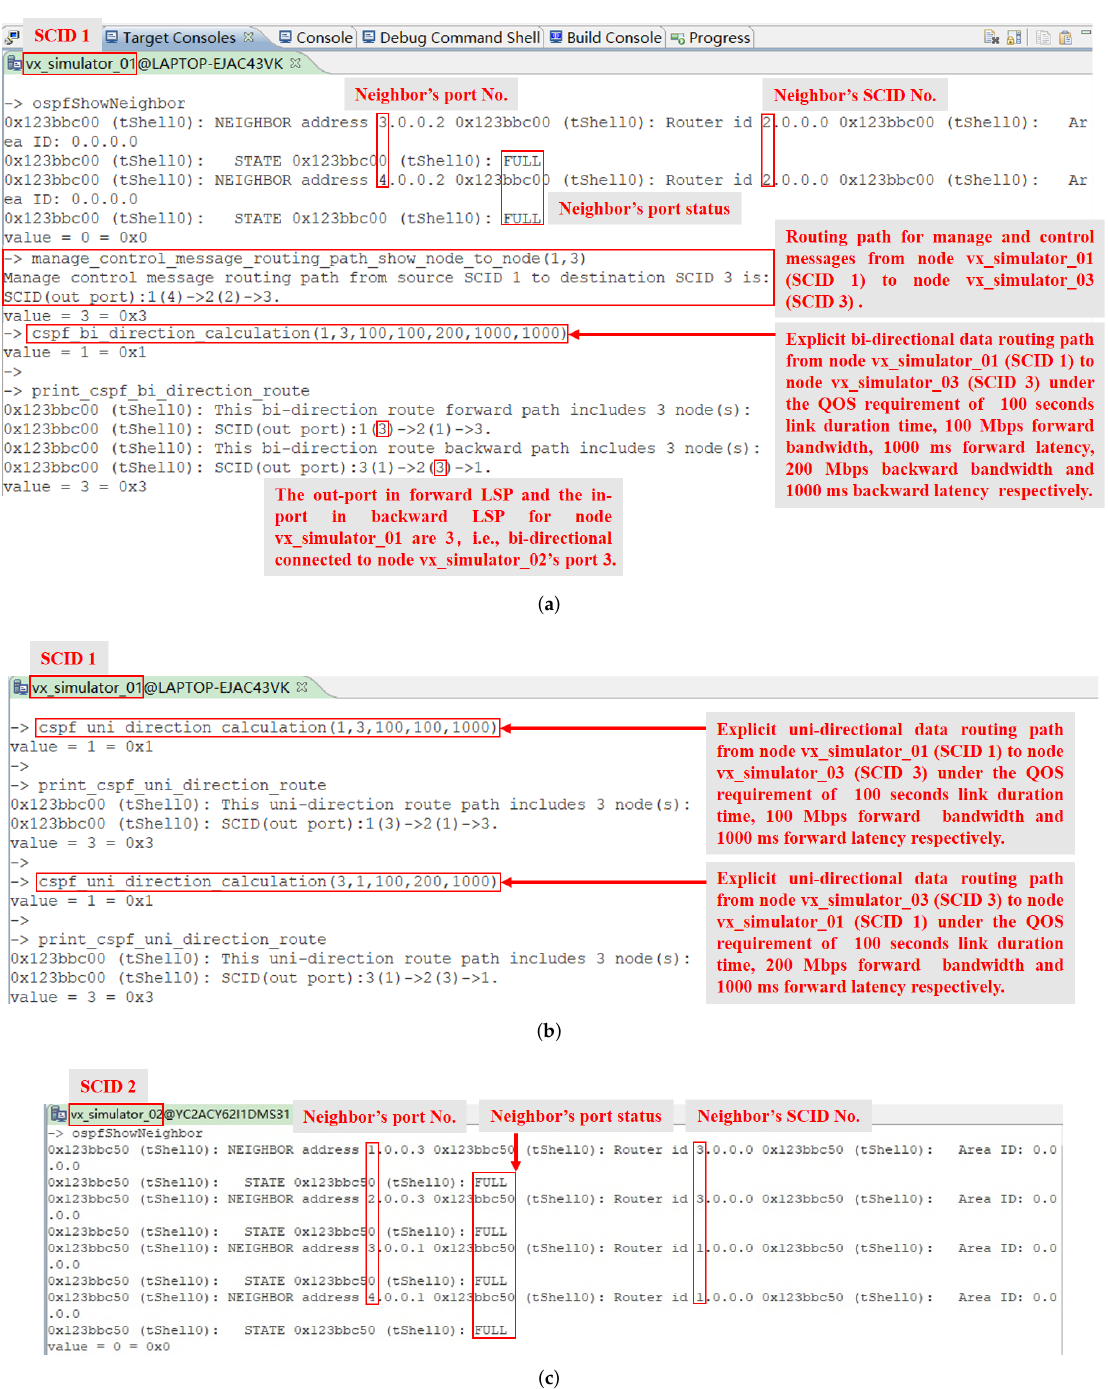
Figure 20. The explicit constraint data routing computation under QoS requirements and the circumstances of a bi-directional link between node vx_simulator_01 (ingress LER, SCID 1), node vx_simulator_02 (LSR, SCID 2), and node vx_simulator_03 (egress LER, SCID 3). ( a ) The status of a neighbor’s port and explicit bi-directional data routing path computation in node vx_simulator_01 (SCID 1). ( b ) The explicit uni-directional data routing path computation between node vx_simulator_01 (SCID 1) and node vx_simulator_03 (SCID 3). ( c ) The status of a neighbor’s port in node vx_simulator_02 (SCID